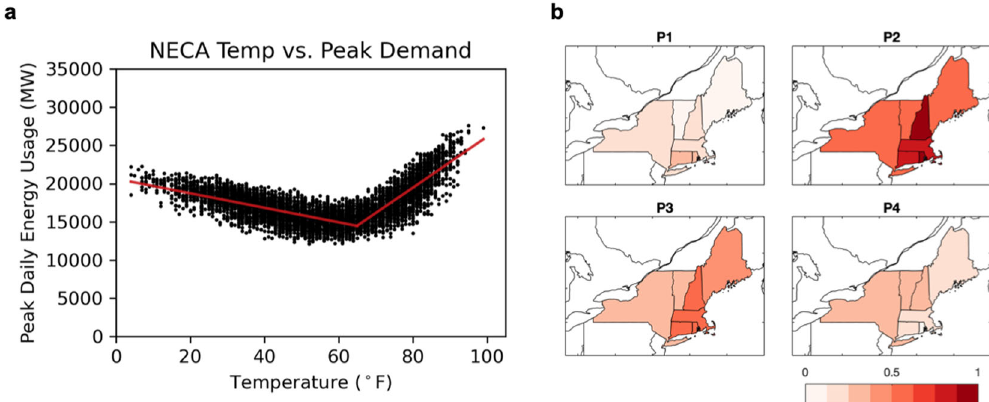
Fig. 6 Electrical demand associated with heat wave patterns. a Maximum daily electrical demand (in MW), 1980 – 2018, for mean regional daily dry-bulb temperature at peak load (°F), according to ISO New England, for the New England Control Area (NECA) encompassing the states of Maine, New Hampshire, Vermont, Massachusetts, Connecticut, and Rhode Island. The red lines show the least squares fi t for data below and above 65°F. b Mean usage by state (shaded, standardized anomalies) for heat wave days in patterns P1 – P4. Standardized anomalies are derived by removing the long-term daily mean (e.g., Jan 01, Jan 02, etc.) from each day ’ s peak demand in the full record, and dividing by the temporal standard